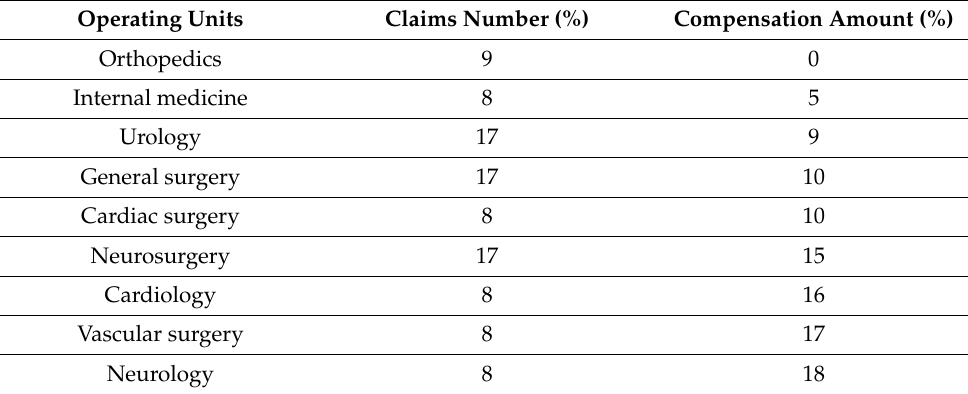
Table 4. HAI: distribution of claims number and compensation amount among operating